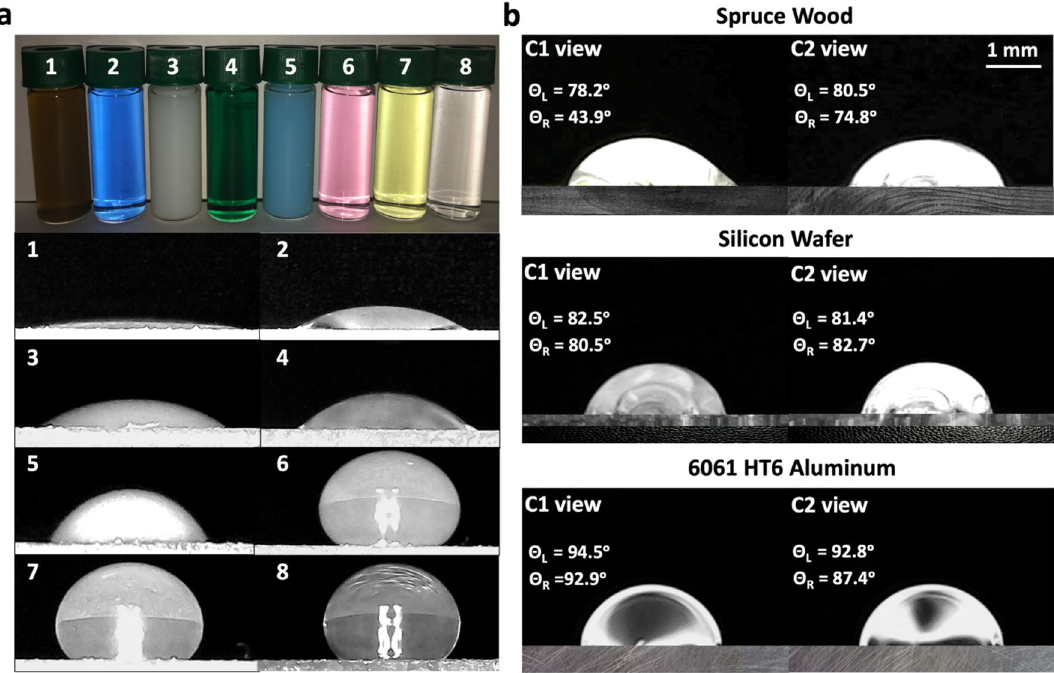
Figure 2. Applicability of front-lit illuminations for CA measurements: ( a ) liquids of varying compositions and colors, where specifically 1 is WD-40 lubricant, 2 is alcohol, 3 is a commercial siloxane, 4 and 5 are polishing oils, 6 and 7 are buffer solutions with pH of 4.0 and 7.0, respectively, and 8 is deionized water on glass slides, ( b ) CA measurements on porous and nonporous surfaces, i.e., spruce wood, silicon wafer, and 6061 HT6 aluminum, showing a clear recognition of the front-lit